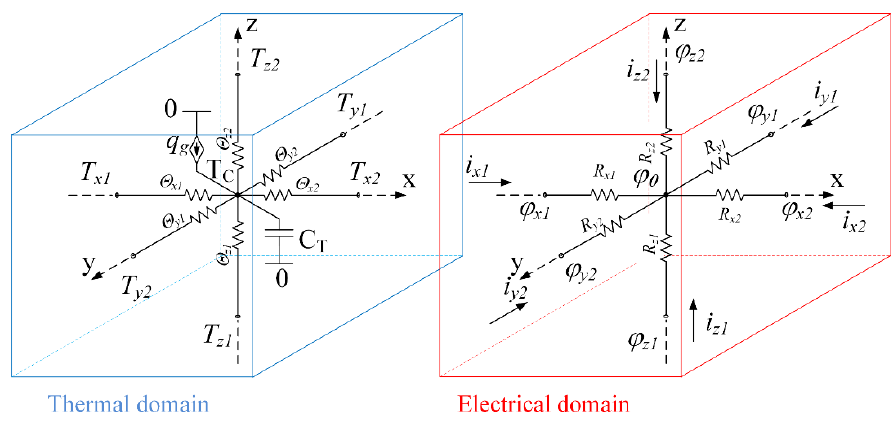
Figure 3. Thermal and electrical domains of the equivalent circuit for mutual simulation of electrical and thermal processes taking place in an elemental volume. The ground of the thermal domain is absolute zero temperature, 0 kelvin. The thermoelectric processes are not included in the model at this stage.